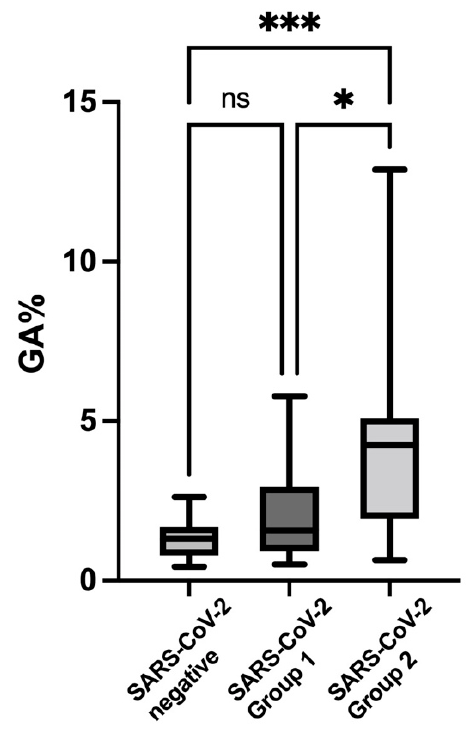
Figure 3. Scatterplot of glycated albumin (GA) percentages (box and whiskers plot) of the SARS-CoV-2 group 1 (1.58; IQR 0.93–2.94) and group 2 subjects (4.26; IQR 1.94–5.08) and the SARS-CoV-2-negative controls (see Figure 1 for values), with multiple post hoc comparisons. *** p value < 0.001, * p value < 0.05 . ns: non significant.